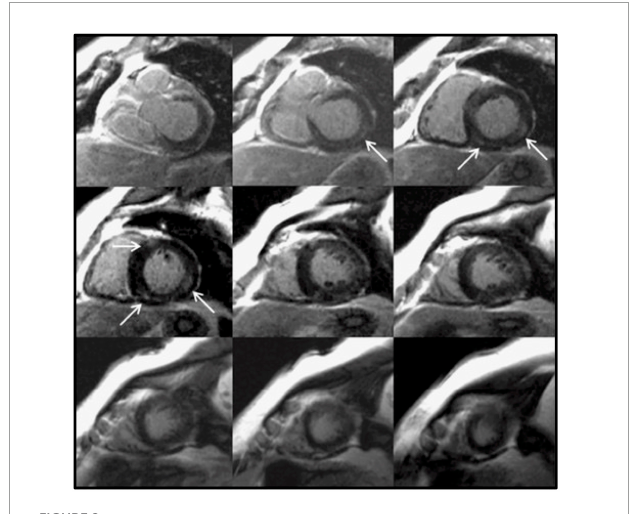
FIGURE2 Focal myocardial fibrosis in a hypertensive patient. Late gadolinium enhancement in a 63-year-old female patient with longstanding hypertension. The arrows show an area of intramyocardial late gadolinium enhancement in the basal and mid inferoseptal and inferolateral segments. This is not the most typical fibrosis pattern in hypertension, which is usually diffuse. Adapted from Maceira et al. with permission